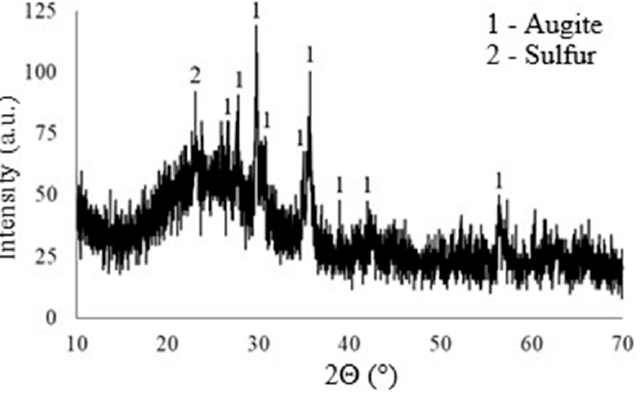
Figure 6. X-ray diffraction patterns of residue after leaching by 28% hydrochloric acid. The residue after hydrochloric acid leaching was dissolved in 4N NaOH solution, then diluted in CCl 4 to remove sulfur and boiled in concentrated hydrochloric acid. The reduction in the residue after decomposition of sample 774 was 68%, and the total de- crease from the initial slag sample was 87%. The residue reduction after decomposition of sample 813 was 44%, and the total decrease from the original slag sample was 65%. Thus, the insoluble part of the slag is about 13% in sample 774 and 35% in sample 813. According to X-ray phase analysis, the basis of the residue after additional treatment is hard-soluble mineral augite (Ca,Mg,Fe,Al)(Si,Al) 2 O (Figure 7). Residue composition, wt.%: 21.7–26.0